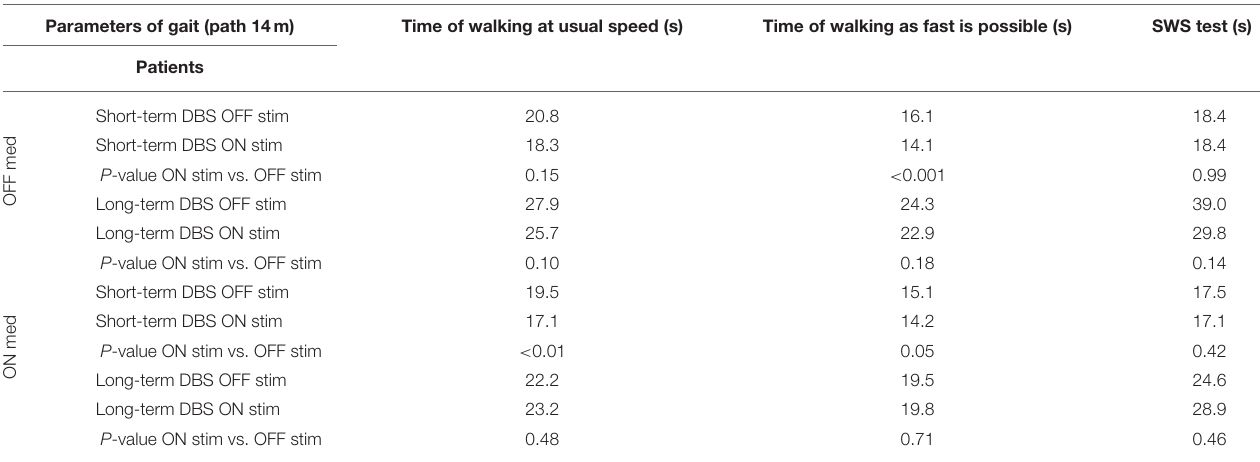
TABLE 2 | Timed gait tasks (GABS III) in all four states in PD patients with short- and long-term stimulation ( P -value). Parameters of gait (path 14m) Time of walking at usual speed (s) Time of walking as fast is possible